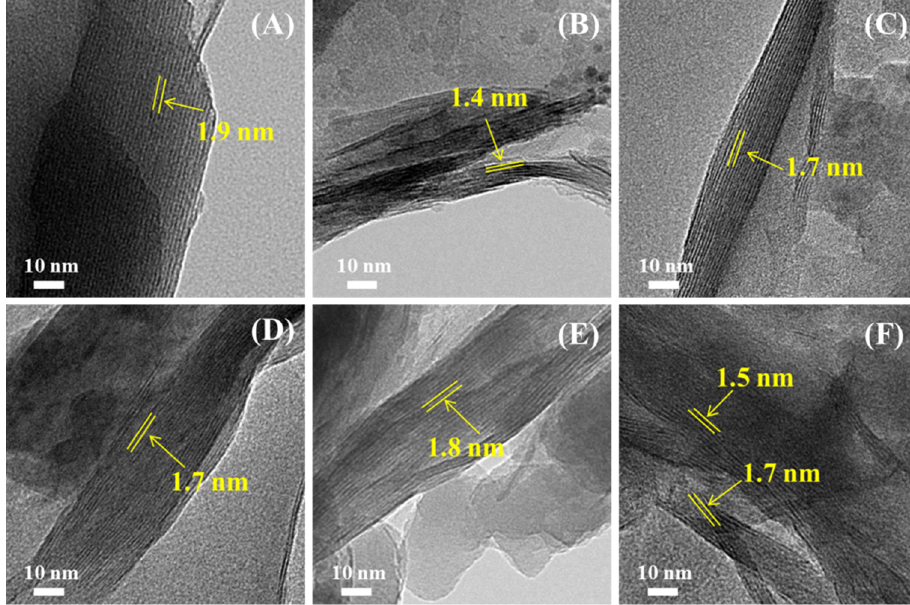
Figure 5. TEM images obtained for ( A ) H-P-Mt, ( B ) H-Si-Mt, ( C ) P-Si-Mt, ( D ) Si-P-Mt, ( E ) H-P-Si-Mt and ( F ) H-Si-P-Mt samples.